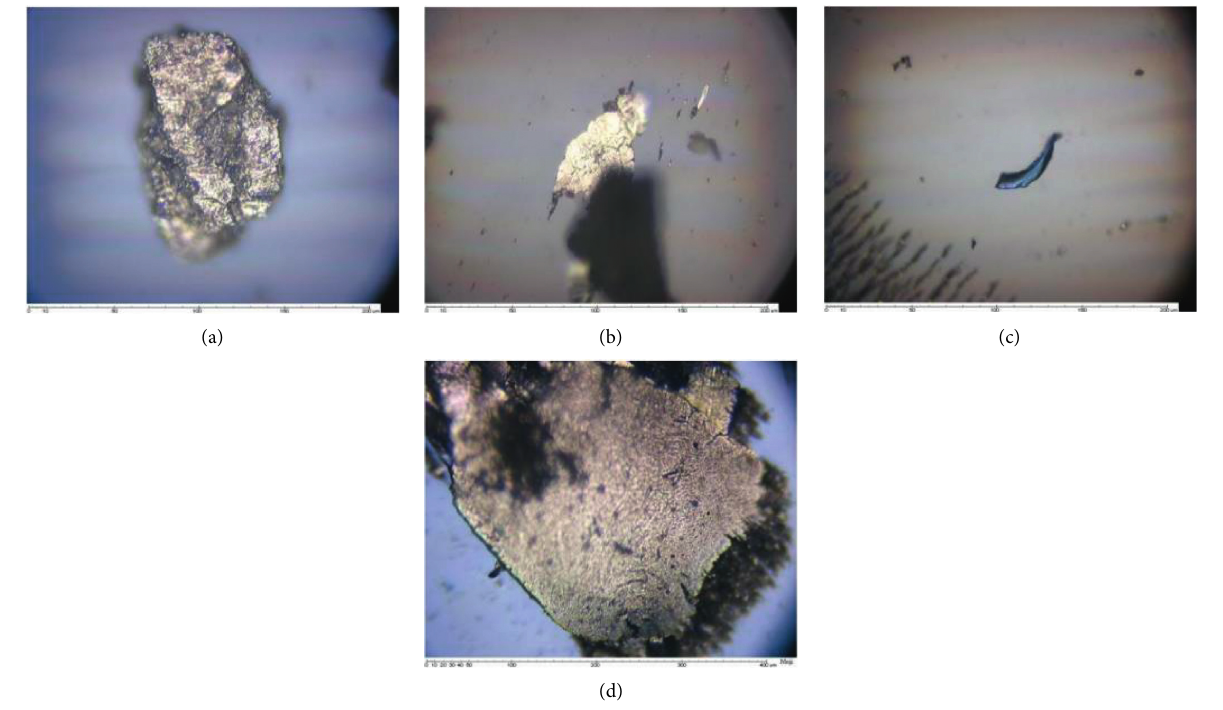
Figure 5: Image examples of wear particles.